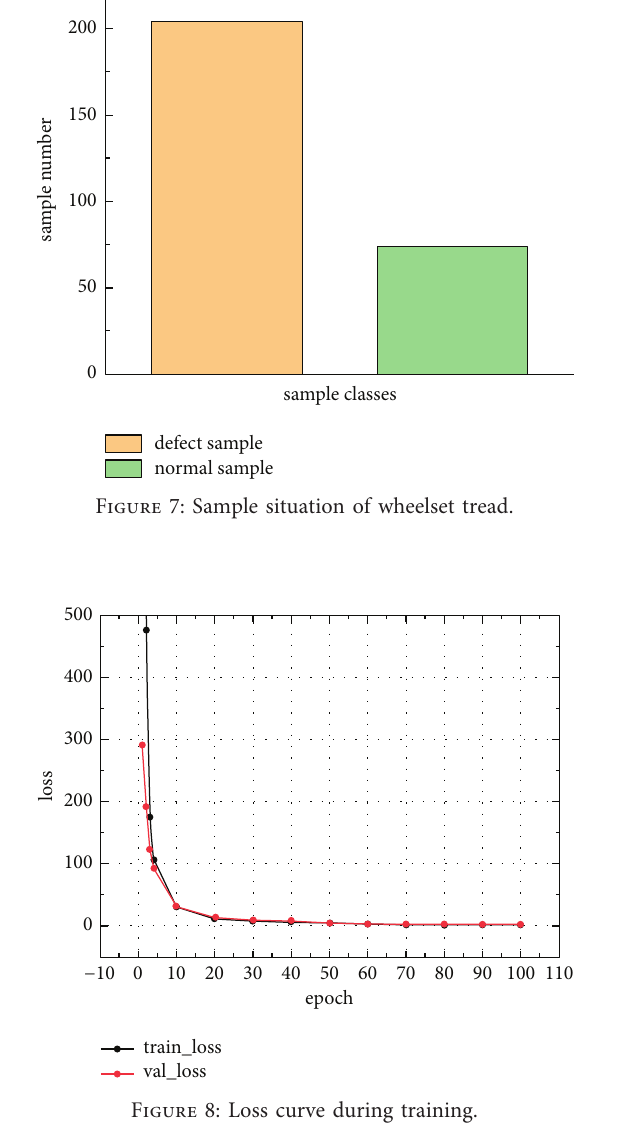
Figure 6: Sample wheelset tread defect dataset, the yellow frame is the ground truth box. (a) Multiple defects. (b) Single defect. Table 2: Detection results on